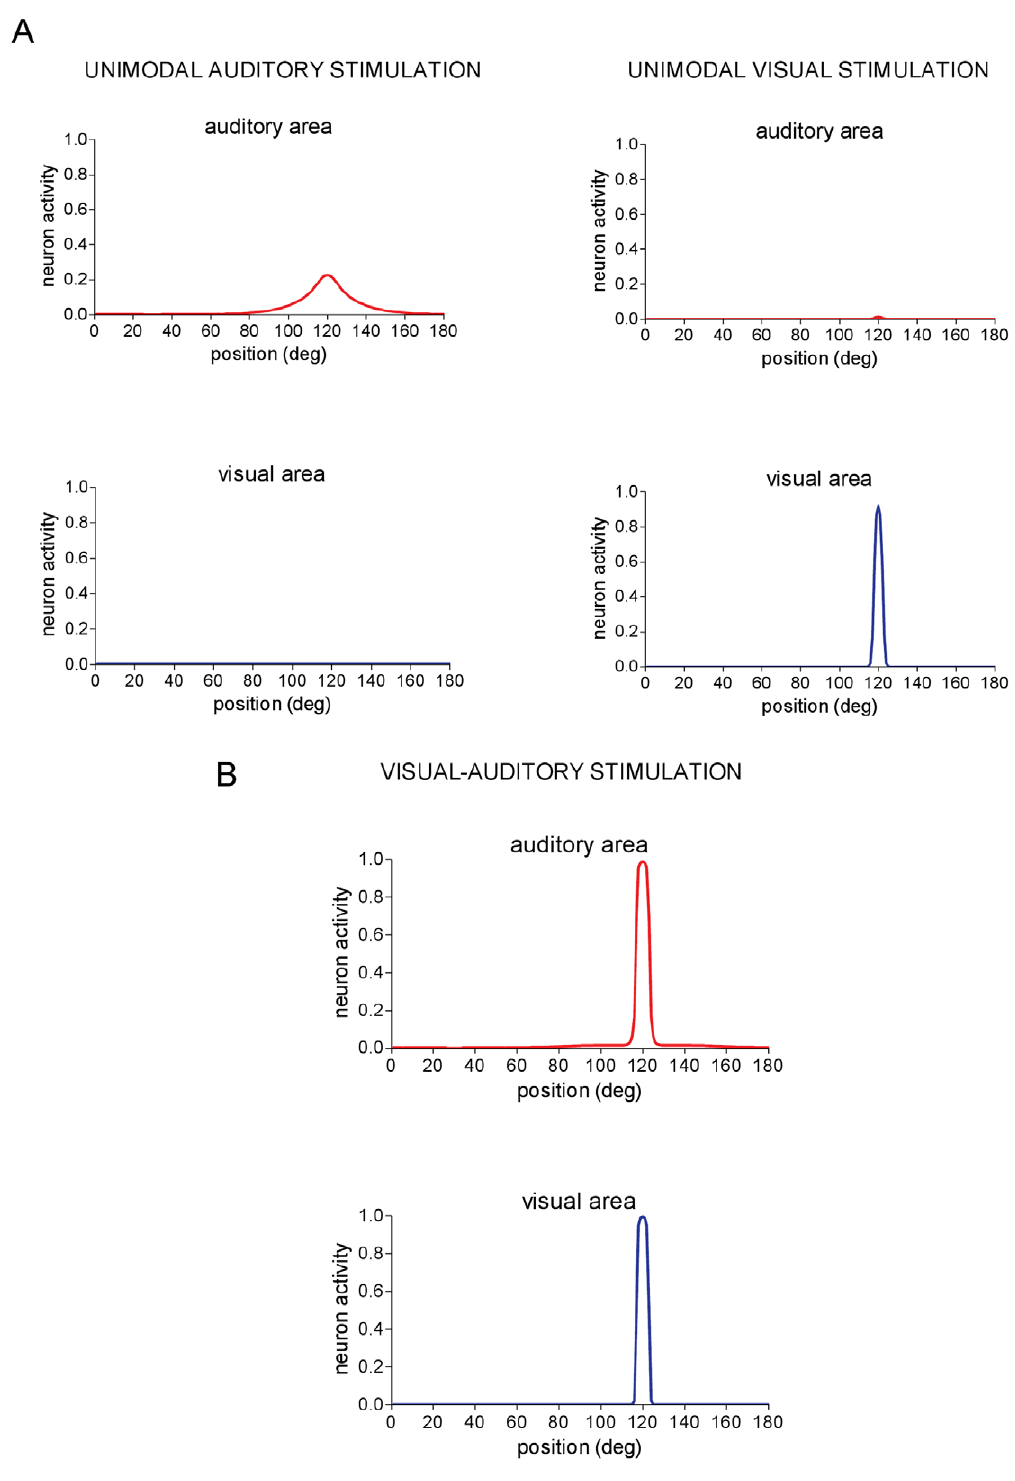
Figure 2. Network response to unimodal stimulation and to cross-modal spatially coincident audio-visual stimulation. ( A ) A unimodal stimulation was applied to the network and maintained constant throughout the entire simulation. Neural activity is shown in the new steady-state reached by the network. Left panels - Neuron activity in the auditory and visual areas in response to an auditory stimulus of amplitude E a =15 applied at position p a =120 u . No activity is elicited in the visual area. Right panels - Neuron activity in the auditory and visual areas in response 0 =15 applied at position p v =120 u . No significant activity is elicited in the auditory area. ( B ) An auditory stimulus to a visual stimulus of amplitude E v 0 and a visual stimulus are simultaneously applied at the same spatial position ( p a = p v =120 u ) and maintained constant throughout the simulation. Network response is shown in steady-state condition. Auditory and visual stimuli have the same strength ( E v narrowing of auditory activation occurs (compare with Fig. 2A, left panels).